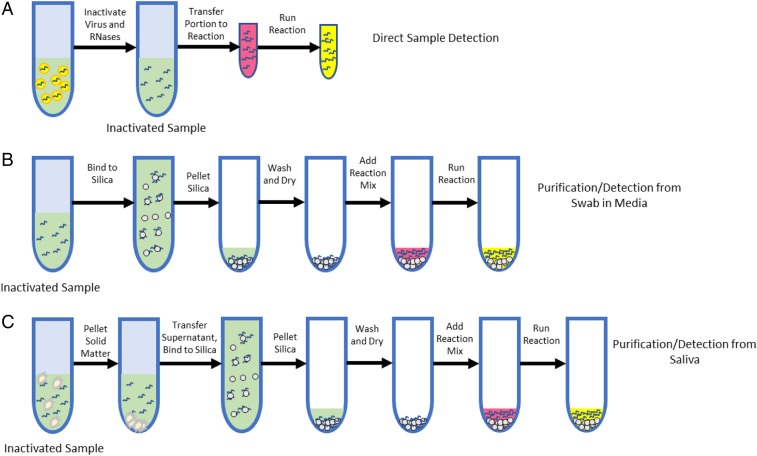
A simple and rapid sample inactivation and purification scheme. (A) A schematic depicting sample inactivation and direct RT-LAMP testing. (B) A schematic of the purification and testing procedure for swab samples postinactivation. (C) A schematic of the purification and testing procedure for saliva samples postinactivation.